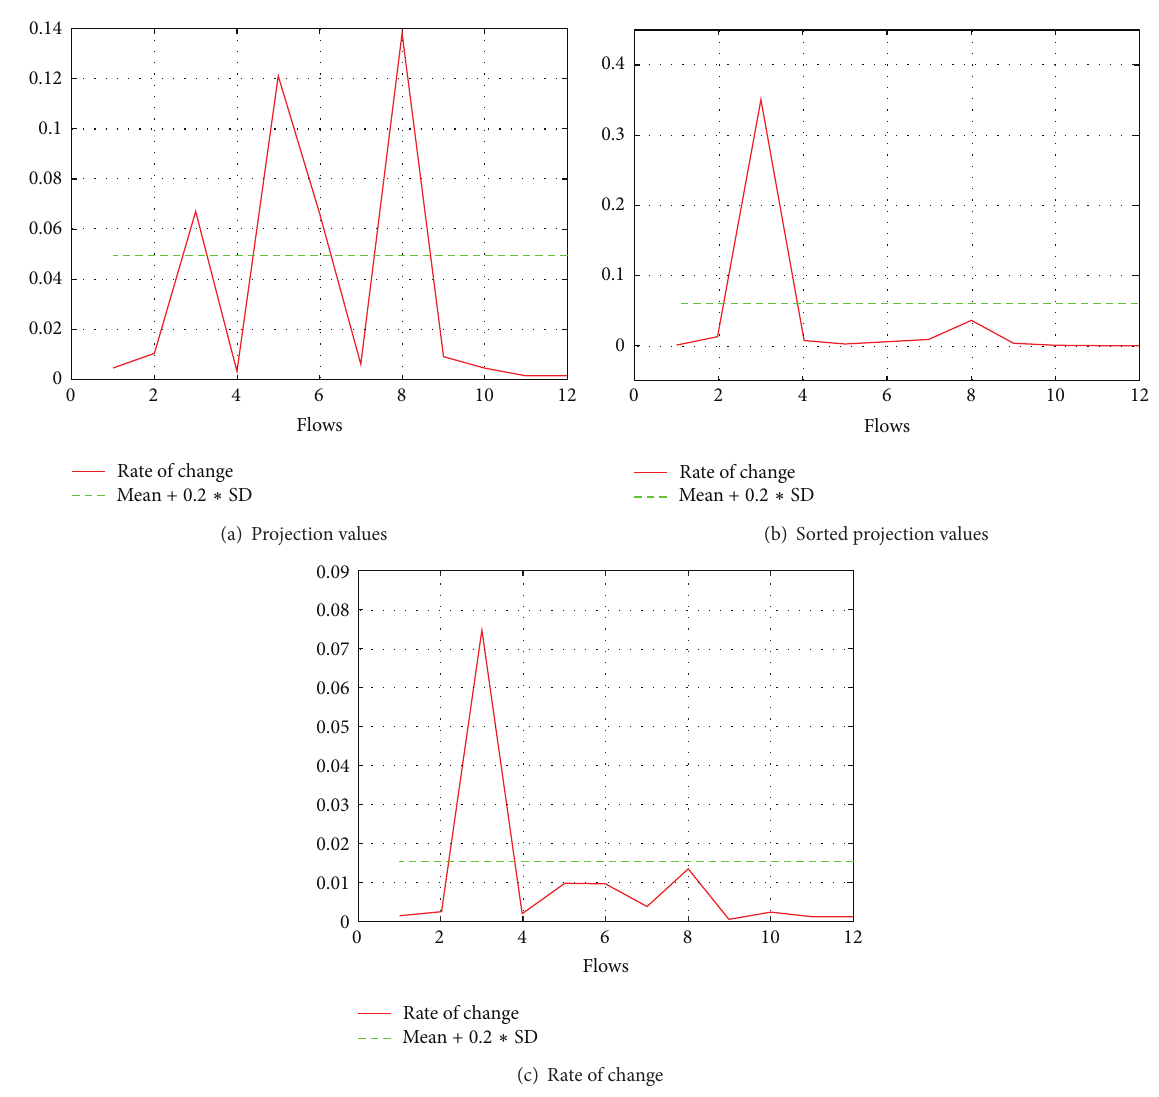
Figure 1: Results in intermediate and final